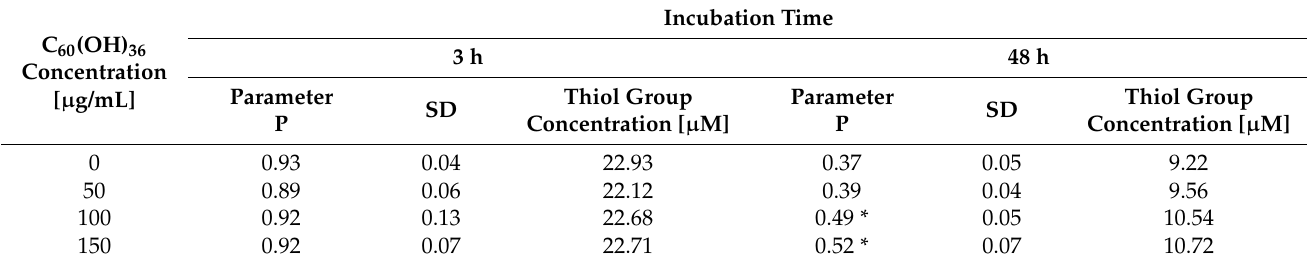
Table 1. Total concentration of -SH groups in erythrocytes incubated at 37 ◦ C with C 60 (OH) 36 .